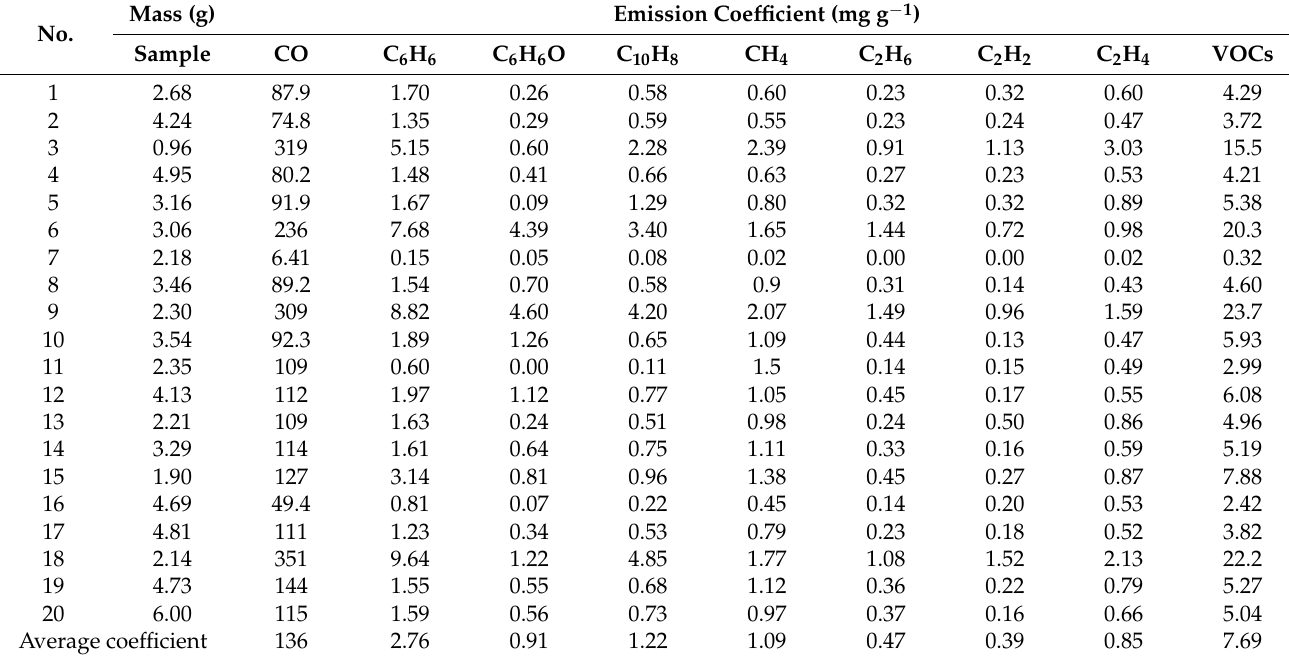
Table 5. The emission factor of CO, VOCs, aliphatic and aromatic hydrocarbons and phenol in the exhaust gases obtained during thermal treatment of waste mobile phones in a fluidised bed.